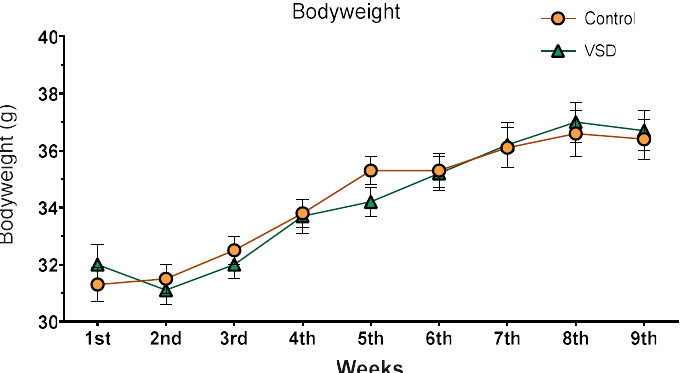
Figure 3. Body weight of mice over 9 weeks. Data are presented as mean ( ± SEM) amount of body weight (control group, n = 20; and VSD group, n = 20).